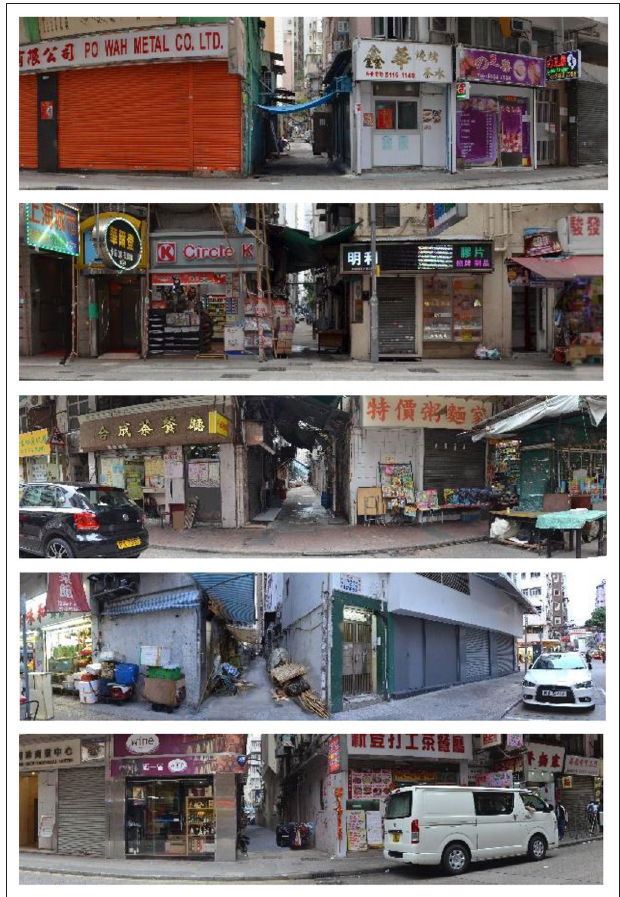
FIGURE 2 | Three experts selected five scenes of urban alleys for this research through a restrictive procedure.